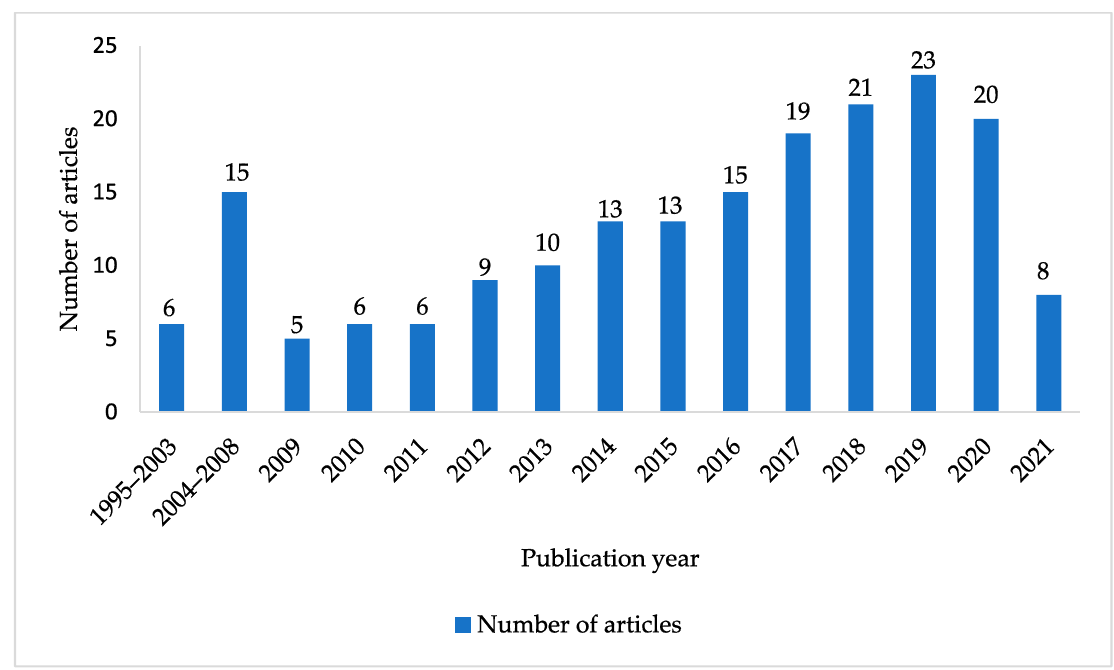
Figure 2. History of relevant publications.